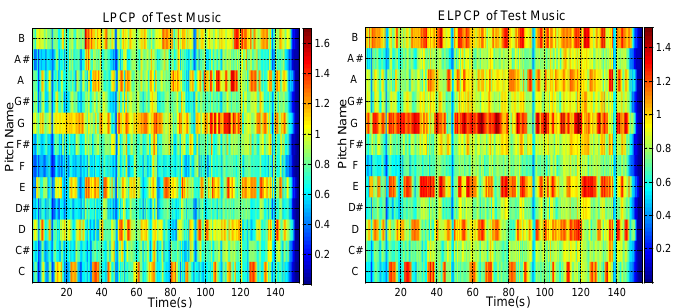
Figure 5. LPCP ( Left ) and ELPCP ( Right ) of test music.